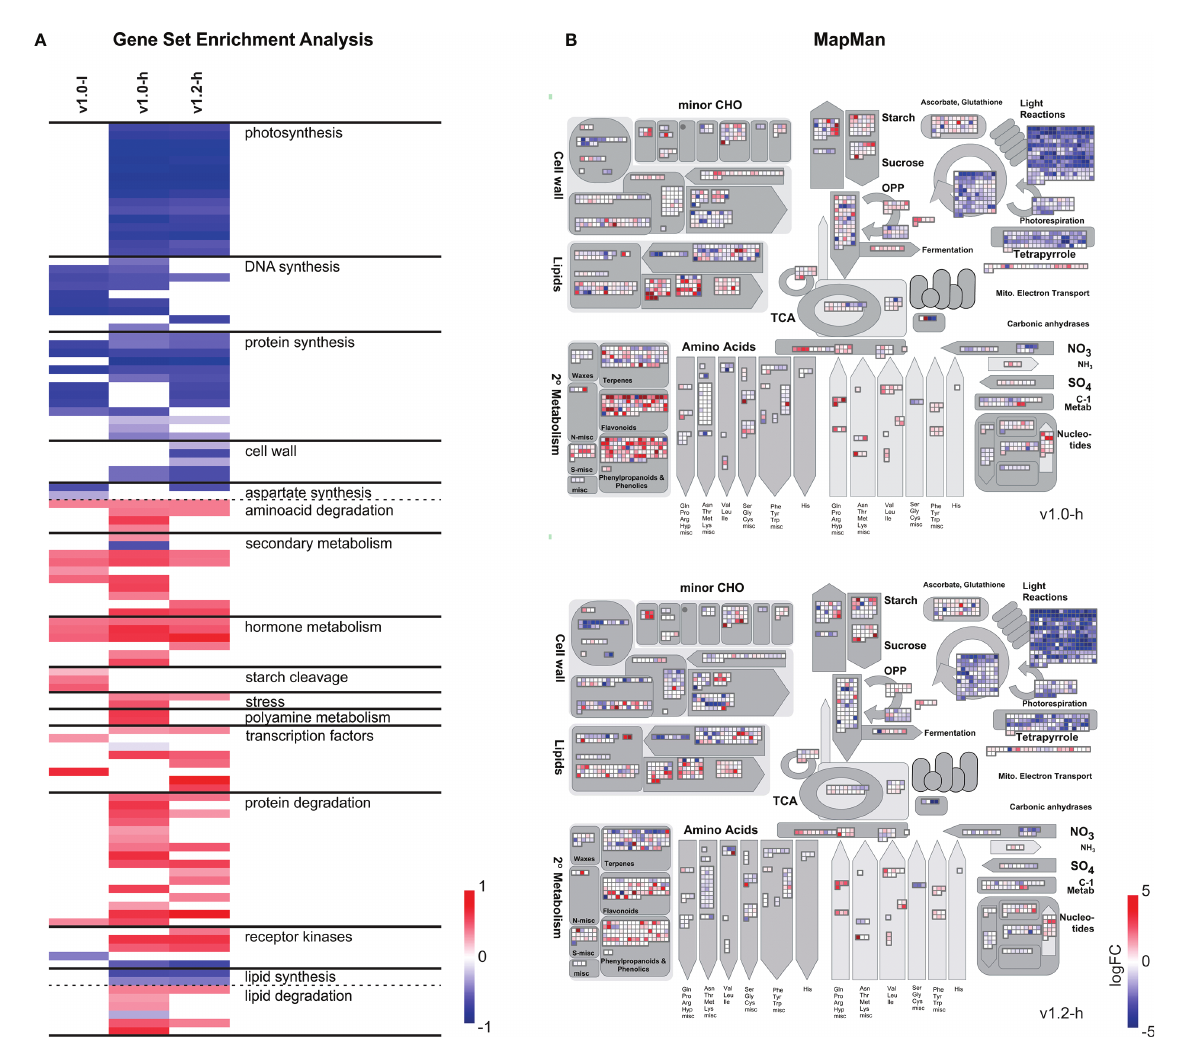
FIGURE 3 Functional analysis of differentially expressed genes in SxP. (A) Gene set enrichment analysis of SxP presented as a heatmap. Gene sets (MapMan BINs) enriched with downregulated genes are shown in blue and gene sets enriched with upregulated genes are shown in red. Contrasting was done for each of the transgenic groups (v1.0-l, v1.0-h, v1.2-h) against wt plants. The colour intensity follows the portion of genes in each gene set that contributed to the enrichment score, as given on the scale at the bottom right of the heatmap. Only selected gene sets with q-value <0.01 are shown, manually grouped into functional clusters given in the fi gure. A full list of enriched gene sets and gene sets depicted in this fi gure is presented in Supplementary Data Sheet S6. (B) MapMan visualisation of metabolism-related differentially expressed genes in SxPv1.0 (top) or SxPv1.2 (bottom) high producers. Only genes with |logFC| > 1 and pAdj < 0.05 in at least one of the comparis ons are displayed. Colour intensities correspond to logFC values (red for positive and blue for negative values) and are given on the